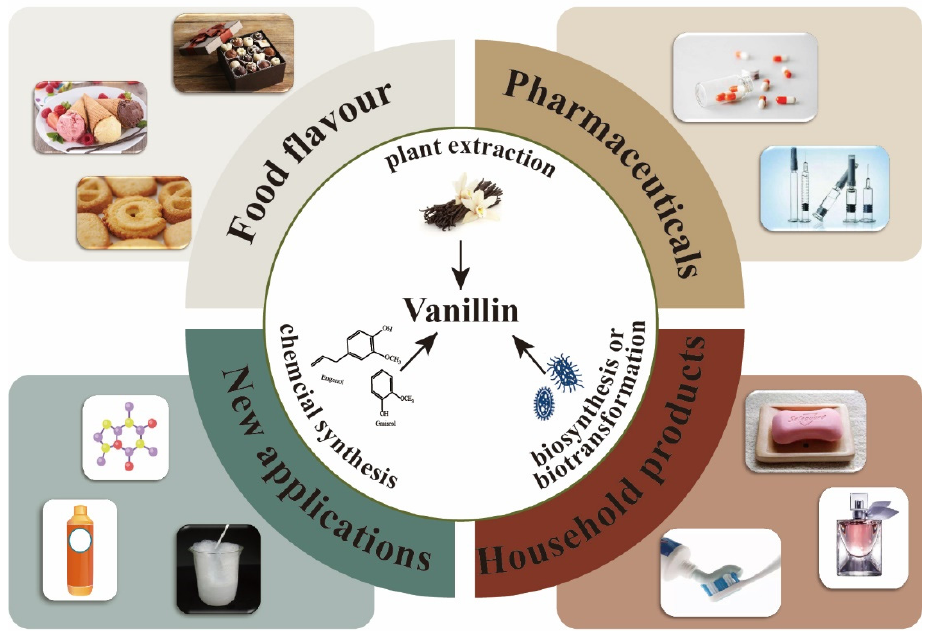
Figure 1. Vanillin production methods and applications.